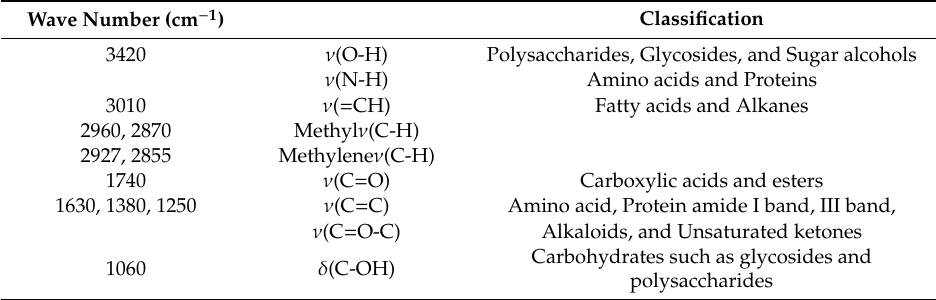
Table 7. Classification of the main absorption characteristic peaks of the infrared spectrum of Chinese wolfberry fruits.